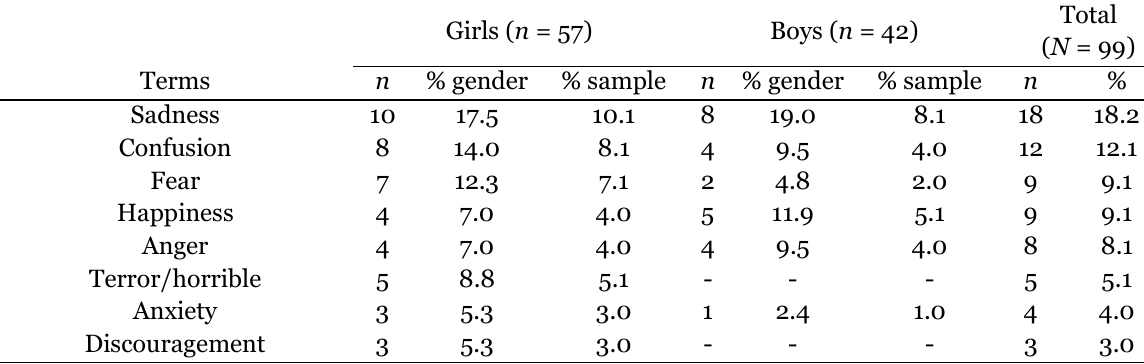
Distribution of Affect-Cognitive Terms Among Girls and Boys